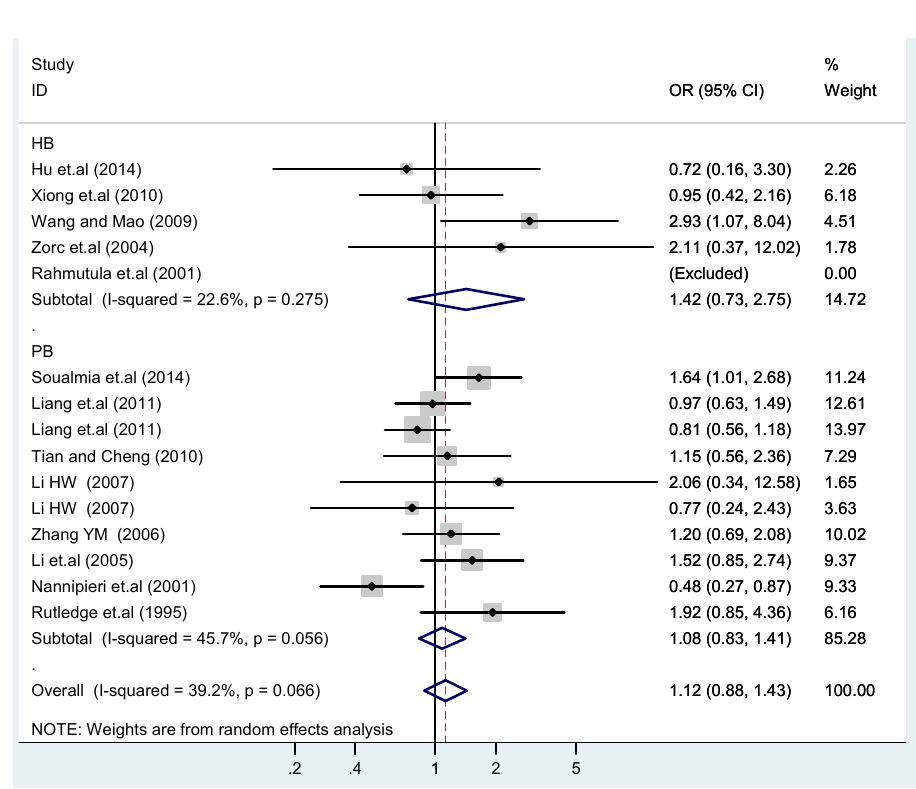
Figure 16. Subgroups in sources of controls of T2238C co-dominant model-2 (CC vs. TT).